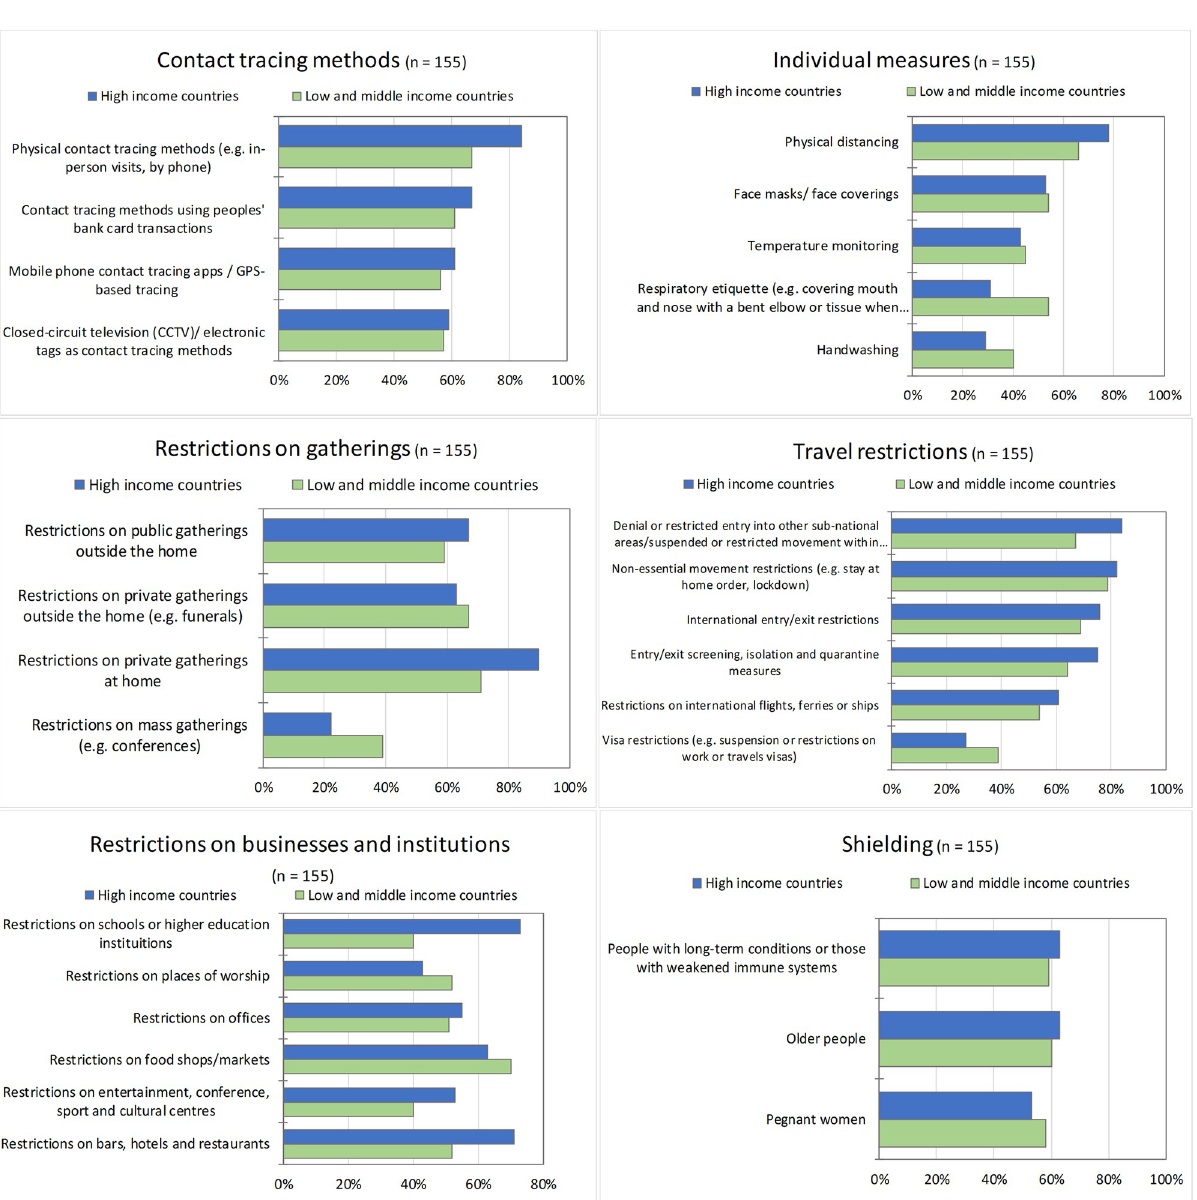
Fig 1. Percentage of respondents rating the following interventions as the most difficult to implement, grouped by intervention type.